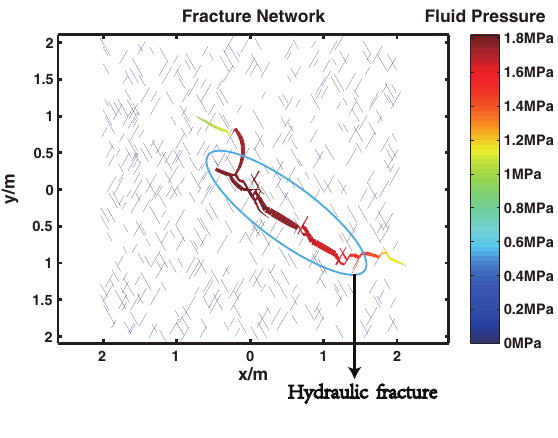
Figure 1. hydraulic